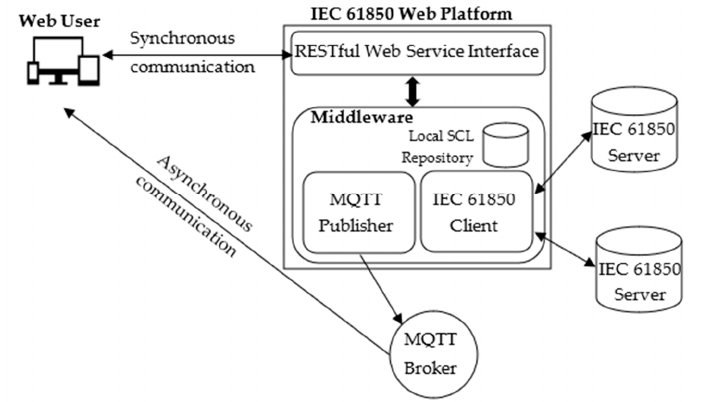
Figure 4. Architecture of the proposed IEC 61850 Web Platform.